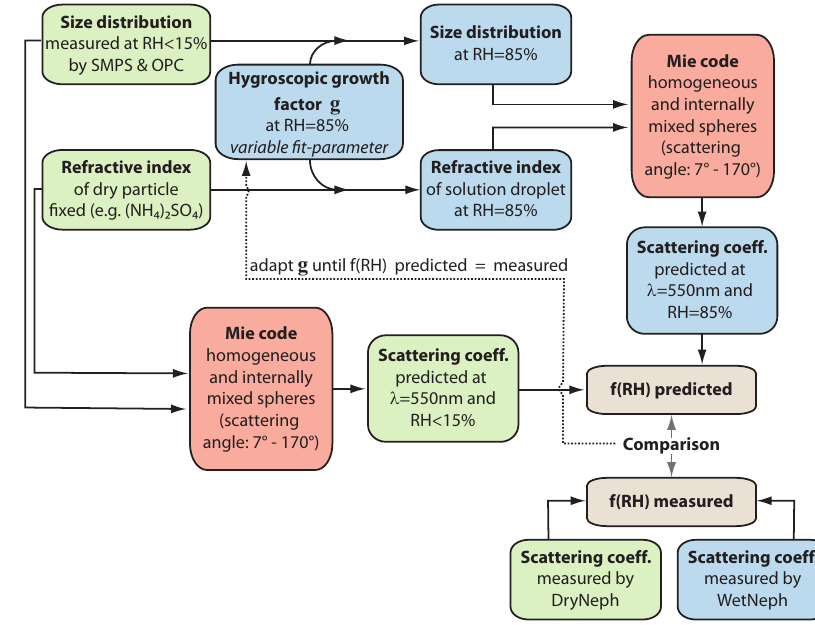
Fig. 1. Scheme of the growth factor retrieval (backward calculation). See text for